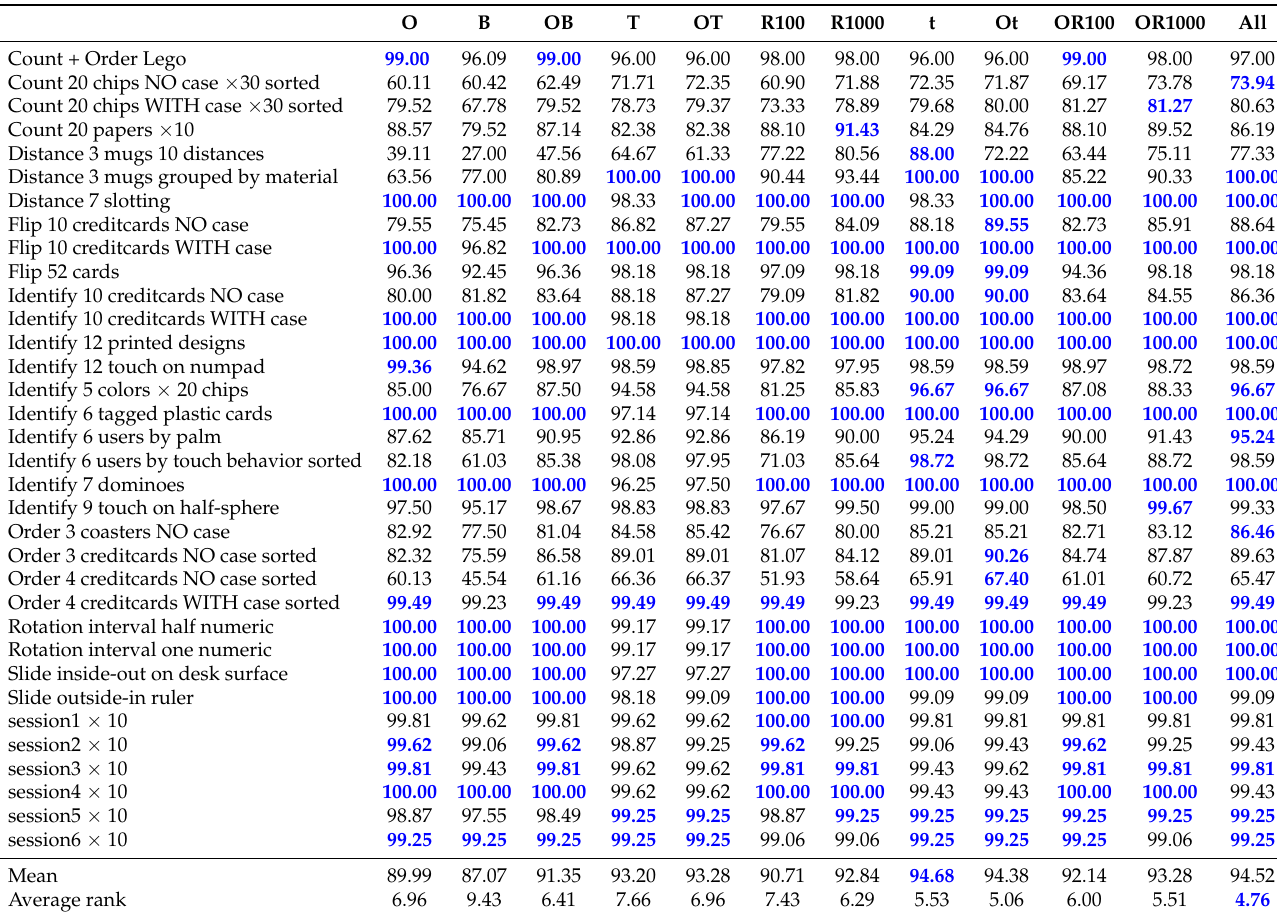
Table A2. Results for classifier SVM-L with different feature sets.